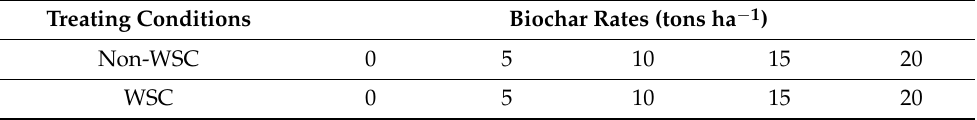
Table 2. Experimental design of different